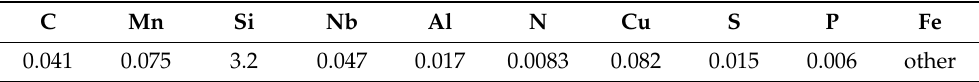
Table 1. Chemical composition of the tested steel (mass fraction,